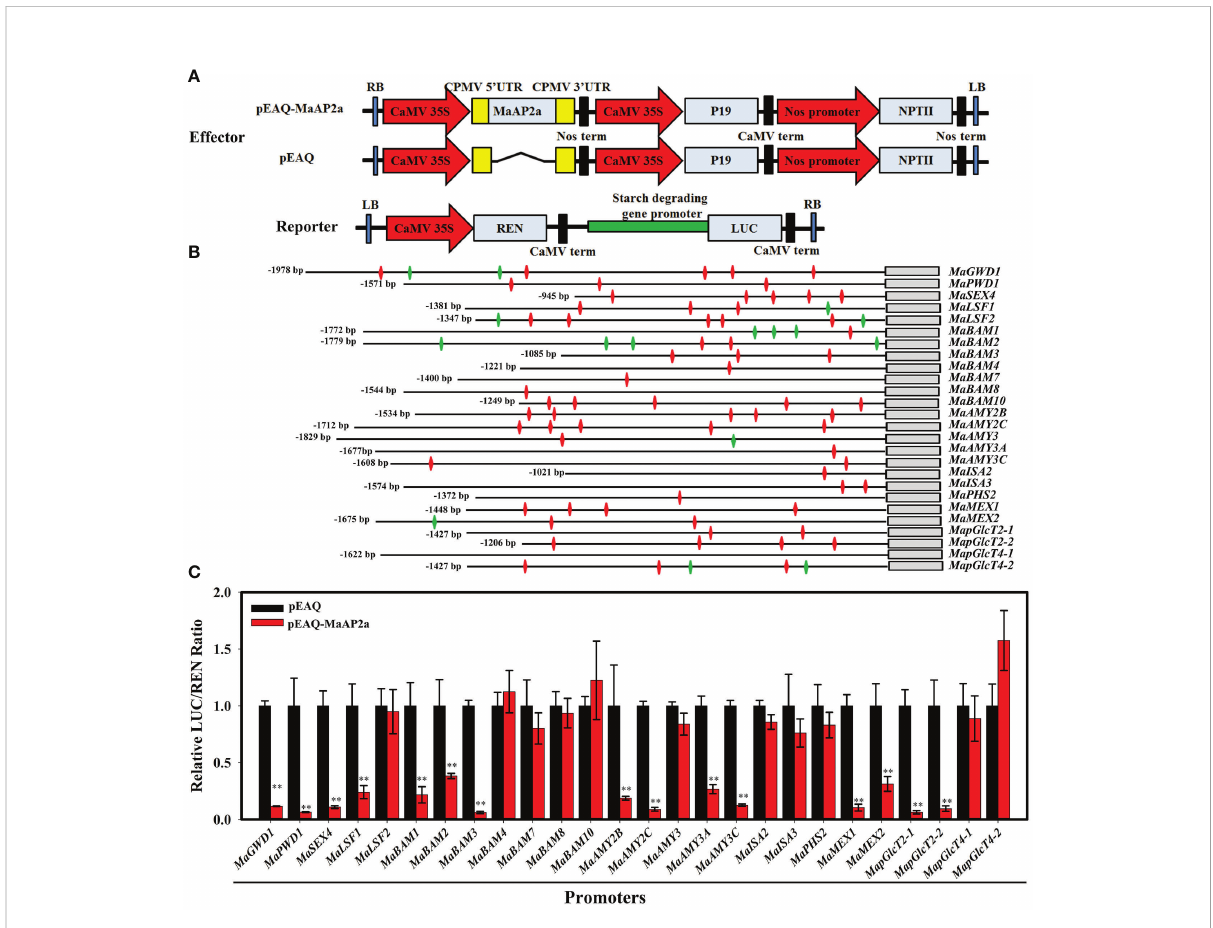
FIGURE 4 DLR ™ Assays of the association of MaAP2a with starch degradation-related gene promoters. (A) Diagrams of the reporter and effector constructs used in the dual-luciferase reporter assay. (B) Schematics of the 26 promoters of genes involved in starch degradation and the annotated length of promoters. Promoter GCC-box and AT-rich motifs are indicated with green and red diamonds, respectively. (C) Transient assays on the inhibition of MaAP2a with the promoters in Nicotiana benthamiana leaves. The ratio of LUC to REN of the empty vector (pEAQ) plus promoter reporter was set as 1. Each value represents the means of six biological replicates, and vertical bars represent the SE. The ** represents signi fi cant differences in p values